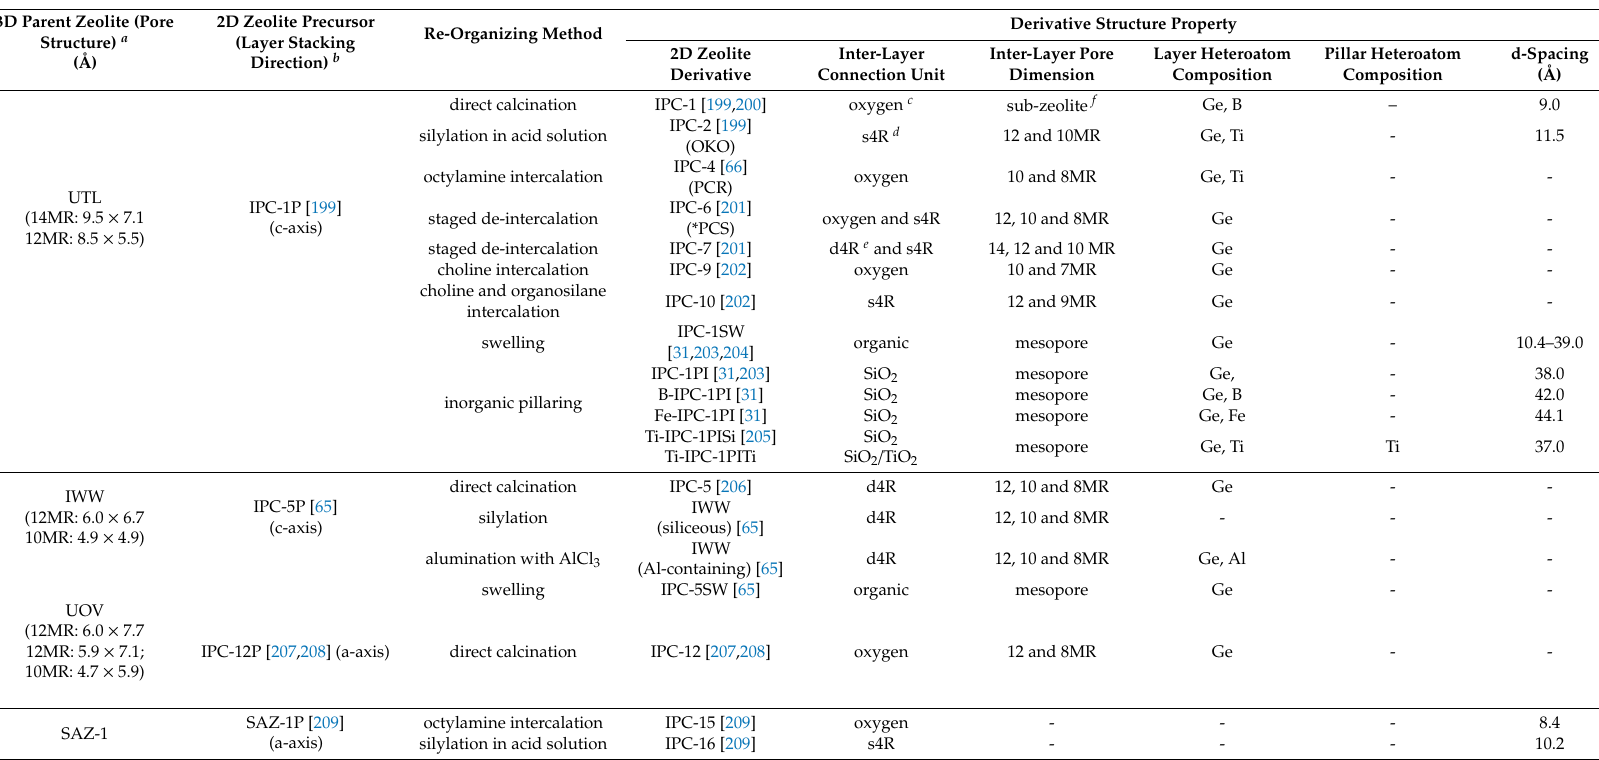
Table 8. Structural and compositional properties of 2D zeolite layers, derivatives, and 3D parent zeolites practiced in the ADOR (assembly–disassembly– organization–reassembly)